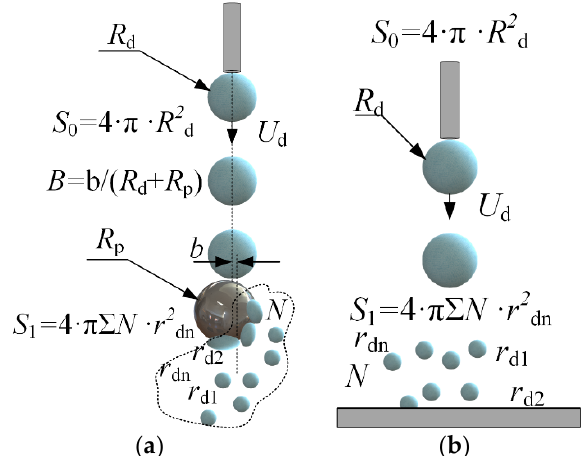
Figure 2. Scheme for calculating the characteristics of droplet-particle ( a ) and droplet-substrate ( b ) collisions.